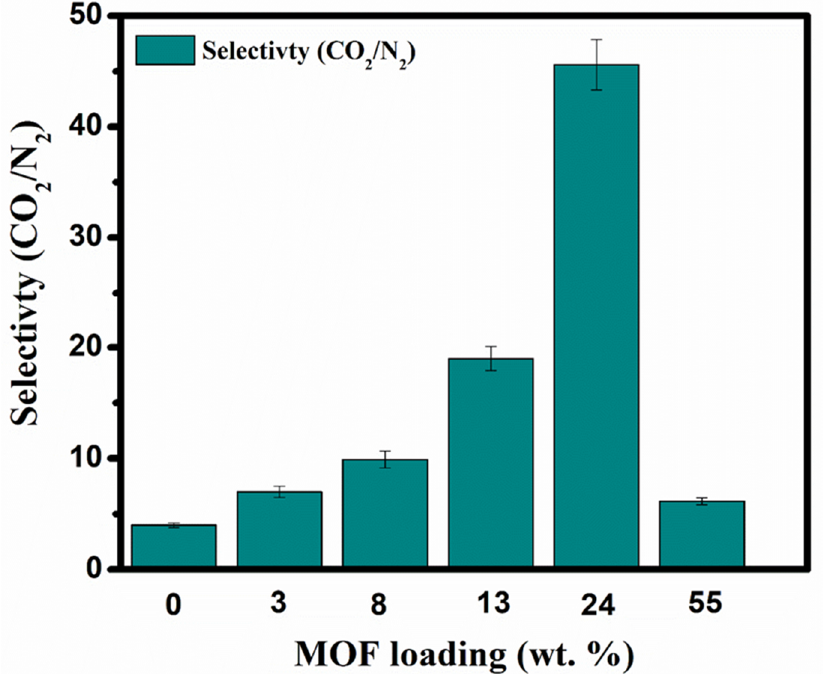
Figure 8. CO 2 and N 2 gas selectivity behavior of PVAm-PVA-UiO-66-NH 2 MMM with different UiO-66-NH 2 loading amounts.